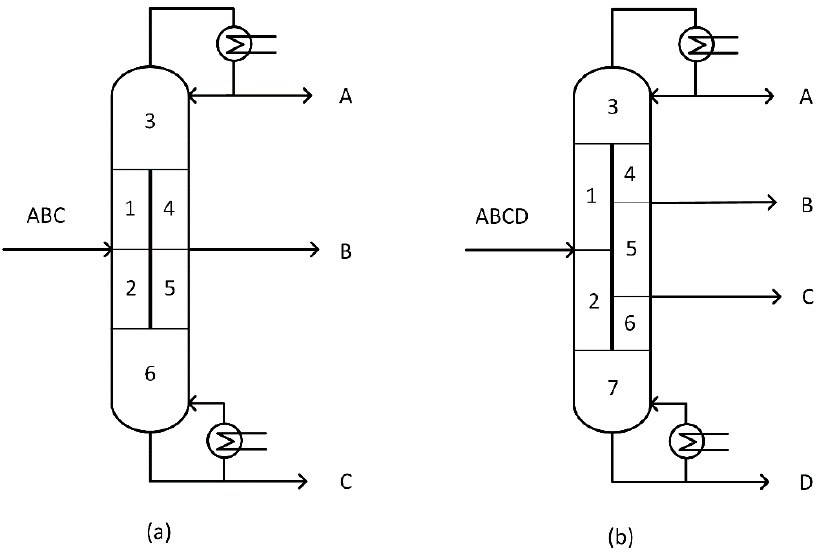
Figure 1. Depiction of DWCs ( a ) three-product DWC and ( b ) four-product DWC, also called Kaibel Column. The separation sections are indicated by the numbers inside the columns.